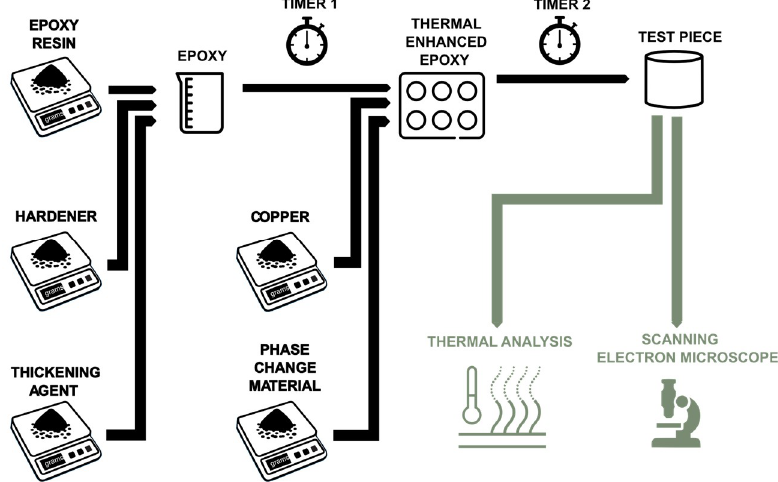
Figure 1. Workflow of the creation and testing of the phase change material (PCM)-epoxy samples .